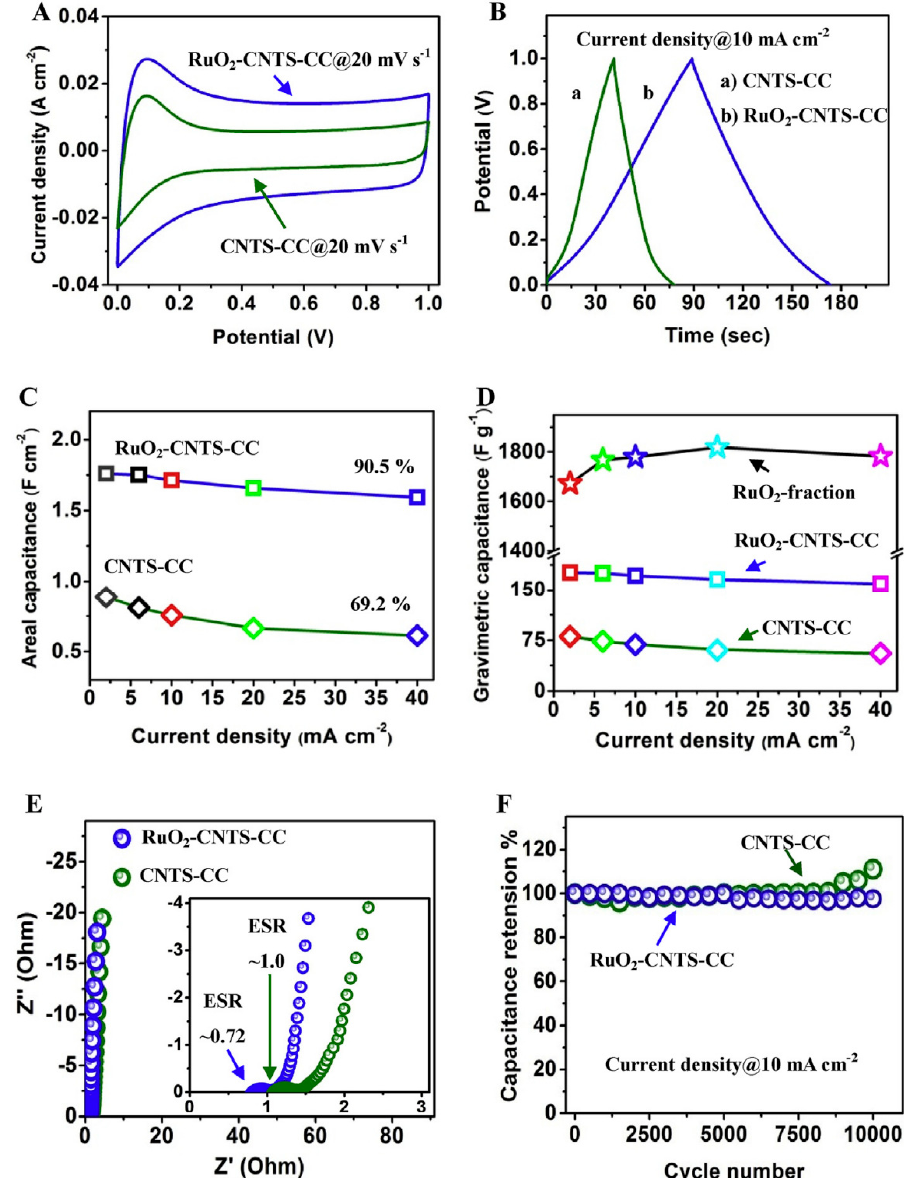
Figure 1. Electrochemical performance of different electrodes in liquid state supercapacitors using 1 M H 2 SO 4 electrolytes: ( A ) comparison of CV at 20 mV s − 1 ; ( B ) GCD curves at 10 mA cm 2 ; ( C ) calculated areal capacitance at a range of current densities; ( D ) calculated gravimetric capacitance at different current densities; ( E ) Nyquist plots of different samples, and the inset showing the corresponding magnified high-frequency regions; and ( F ) cyclic stability over 10,000 cycles at 10 mA cm − 2 . Reproduced with permission from [62]. Copyright 2019 Elsevier. CNTS-CC, carbon nanotubes grown carbon cloth. CV, cyclic voltammetry. GCD, galvanostatic charge-discharge. ESR, equivalent series